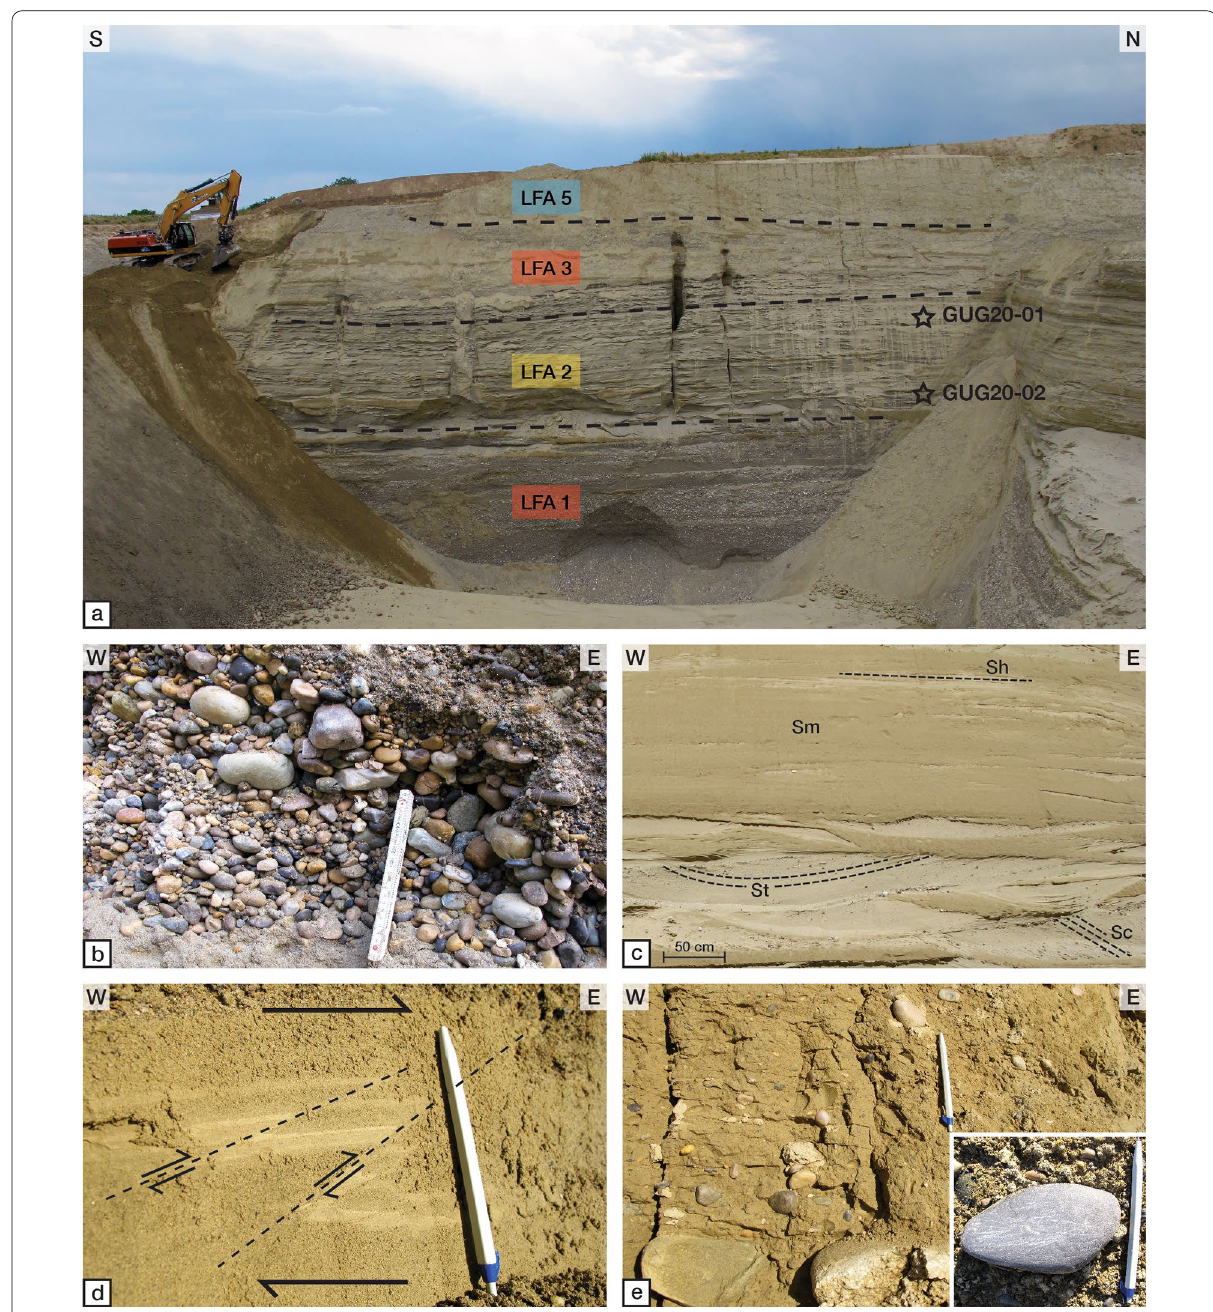
Fig. 4 a Succession at the MÜN pit including photos of the lithofacies associations: LFA 1—Alternation of gravel and sand beds, fining upward; LFA 2—Amalgamation of sand beds with projected locations of IRSL samples GUG20-01 and GUG20-02; LFA 3—Alternation of gravel and sand beds, coarsening upward; and LFA 5—Matrix-supported diamict enriched in quartzite, granite, and metamorphic pebbles. b Grain-supported gravel bed of LFA 1 with few crushed pebbles. c Amalgamation of massive, horizontally bedded, and cross-bedded sand beds (Sm, Sh, and Sc (St: trough-cross-bedded); Table 2) in LFA 2. d Sheard silt and clay layer in a sand bed in the lower part of LFA 3. e Pebbles and boulders embedded in a silt and sand matrix represent the diamict of LFA 5. Bottom right: Polished, striated, and bullet-shaped dark